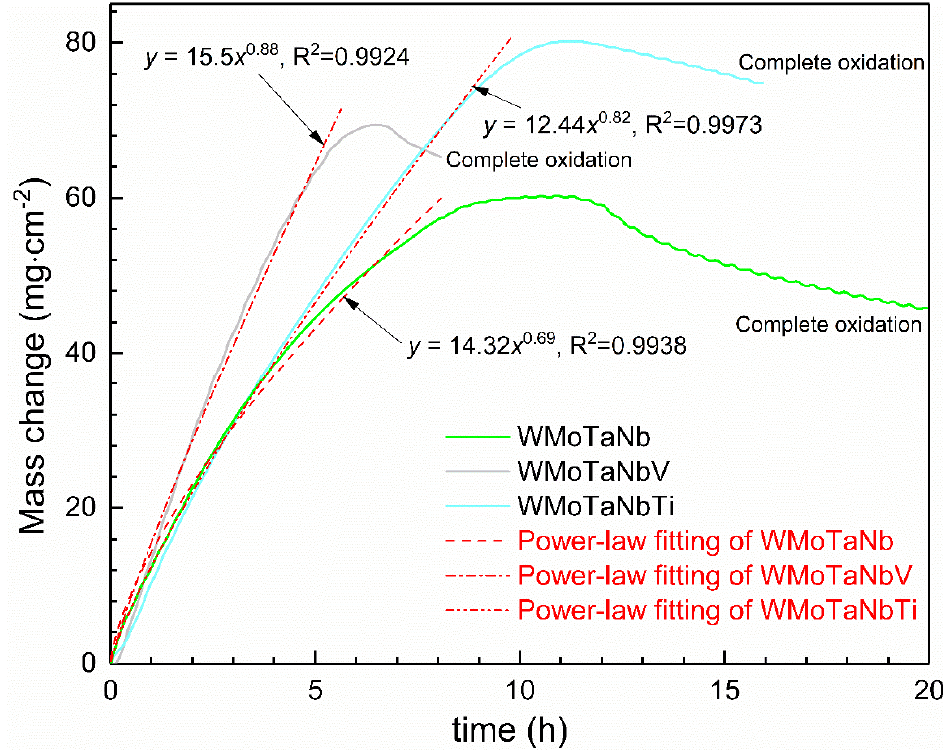
Figure 2. The oxidation kinetics of WMoTaNb, WMoTaNbV and WMoTaNbTi RHEAs during isothermal exposure to dry air at 1000 °C.